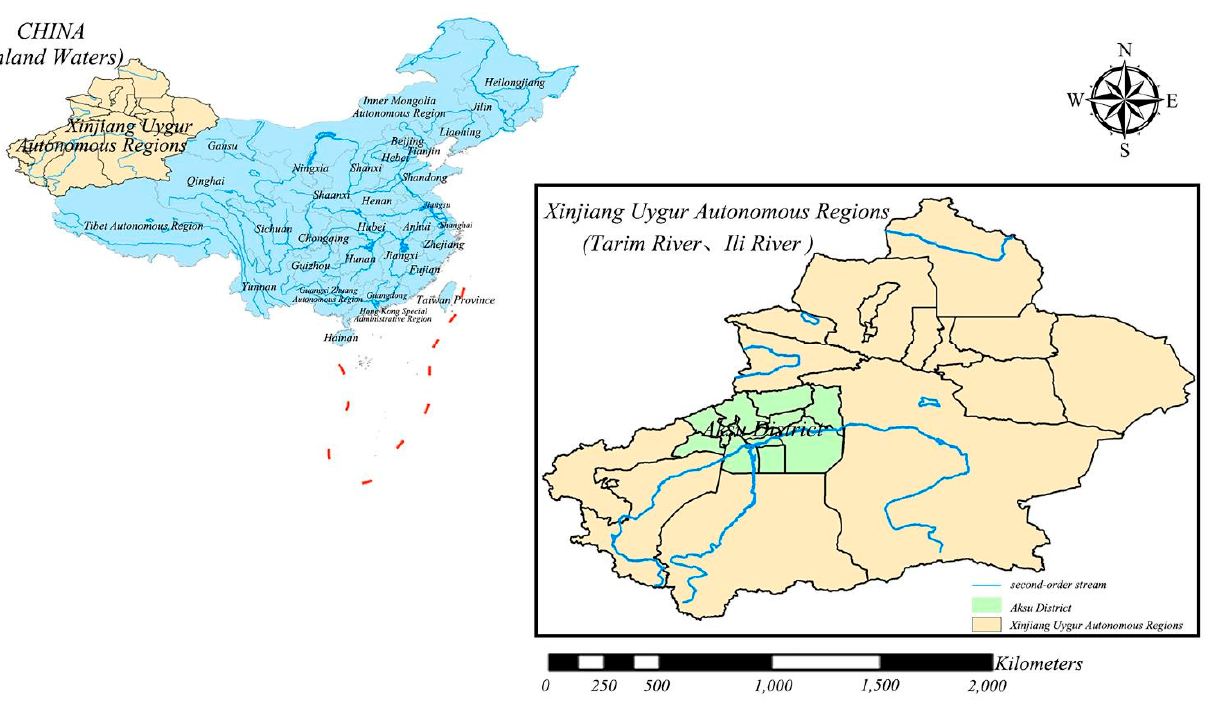
Figure 1. Study area map in Xinjiang. Table 1. Descriptive Statistics of Variables